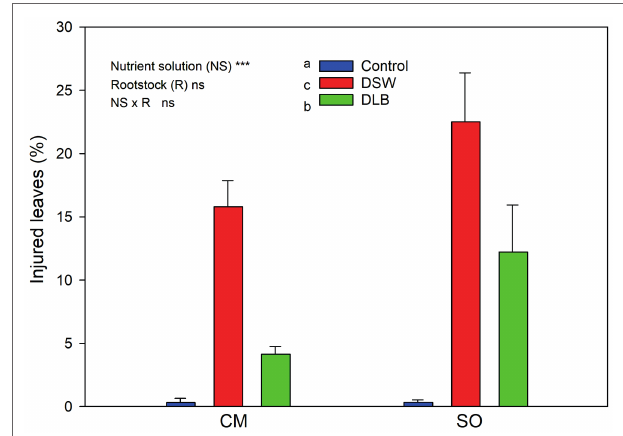
FIGURE 3 | Effects of 7 months of irrigation with nutrient solutions of different characteristics—Control, DSW, and DLB—on the percentage of injured leaves of ‘Verna’ lemon plants grown on two rootstocks, Citrus macrophylla (CM) and sour orange (SO).